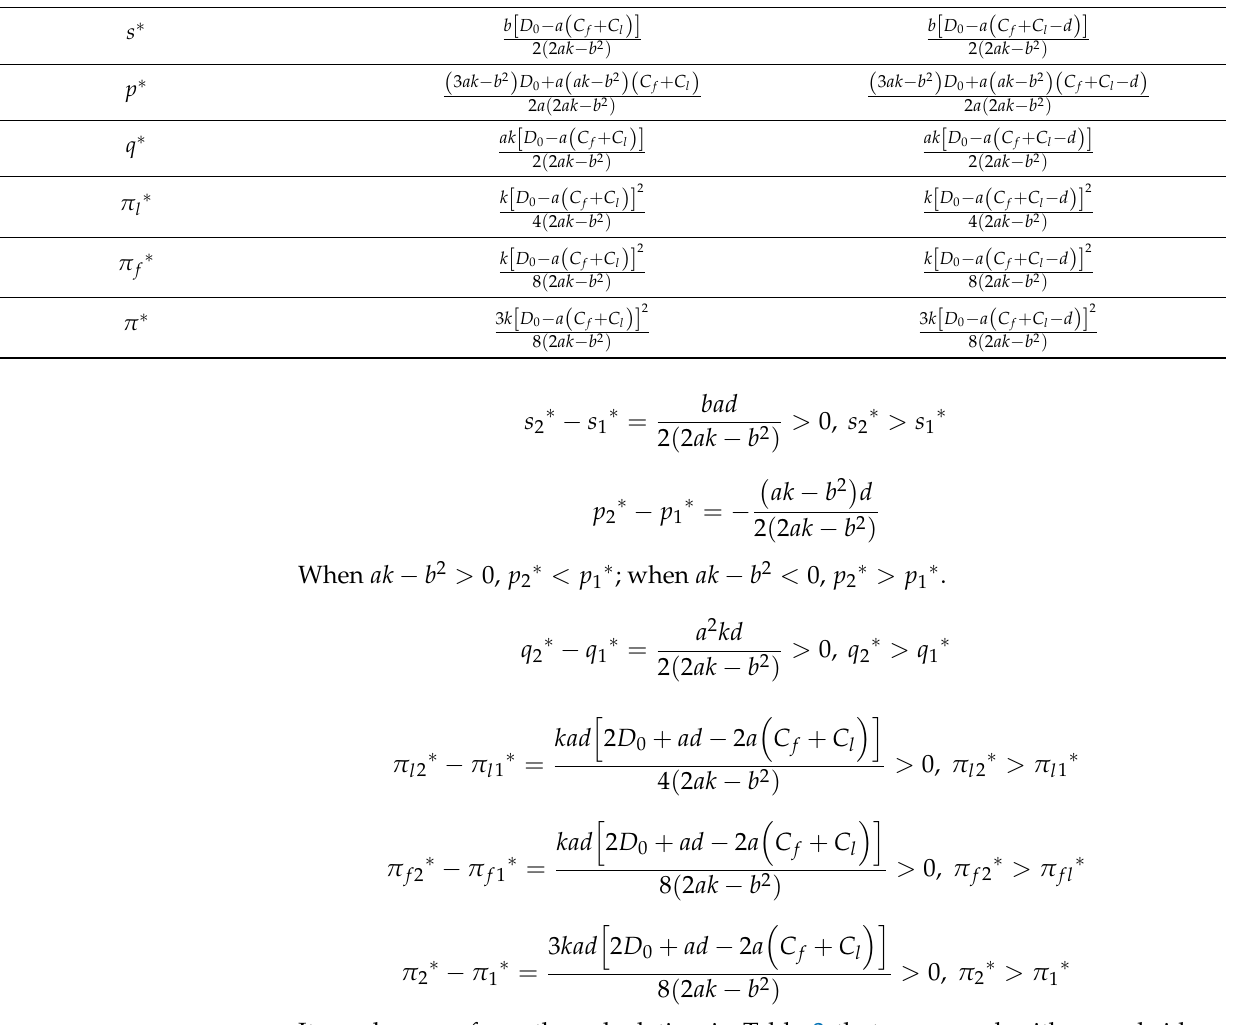
Table 3. Comparison of non-government subsidies and subsidizes the farmer. Parameter Non-Government